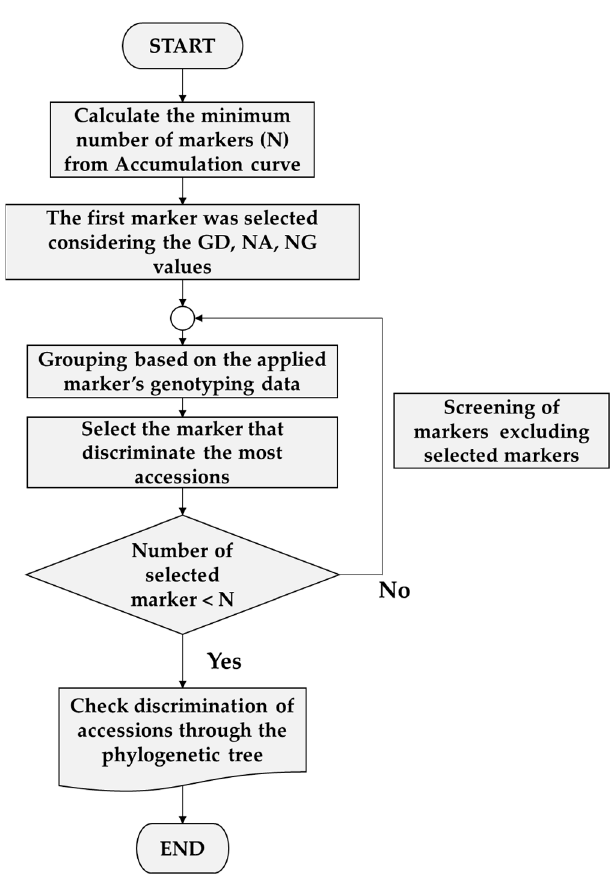
Figure 1. Pipeline used for minimum marker set selection.